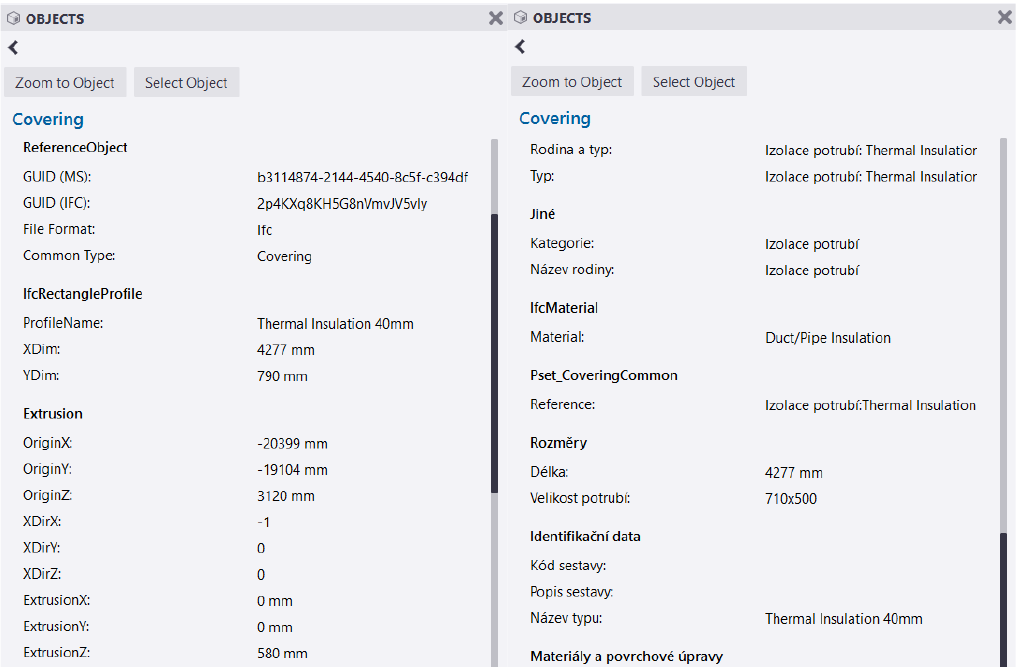
Figure 5: Information on the selected model element, [authors]